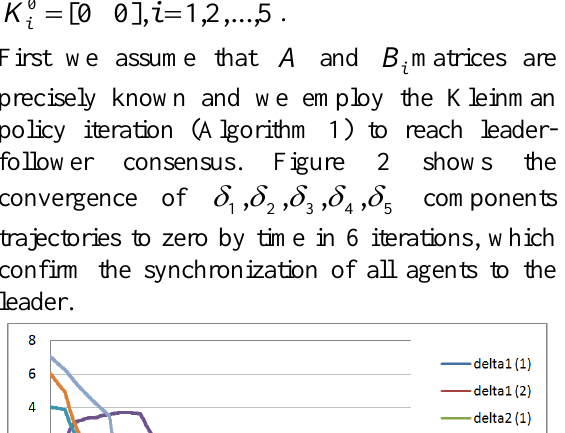
Figure 3. Convergence of k